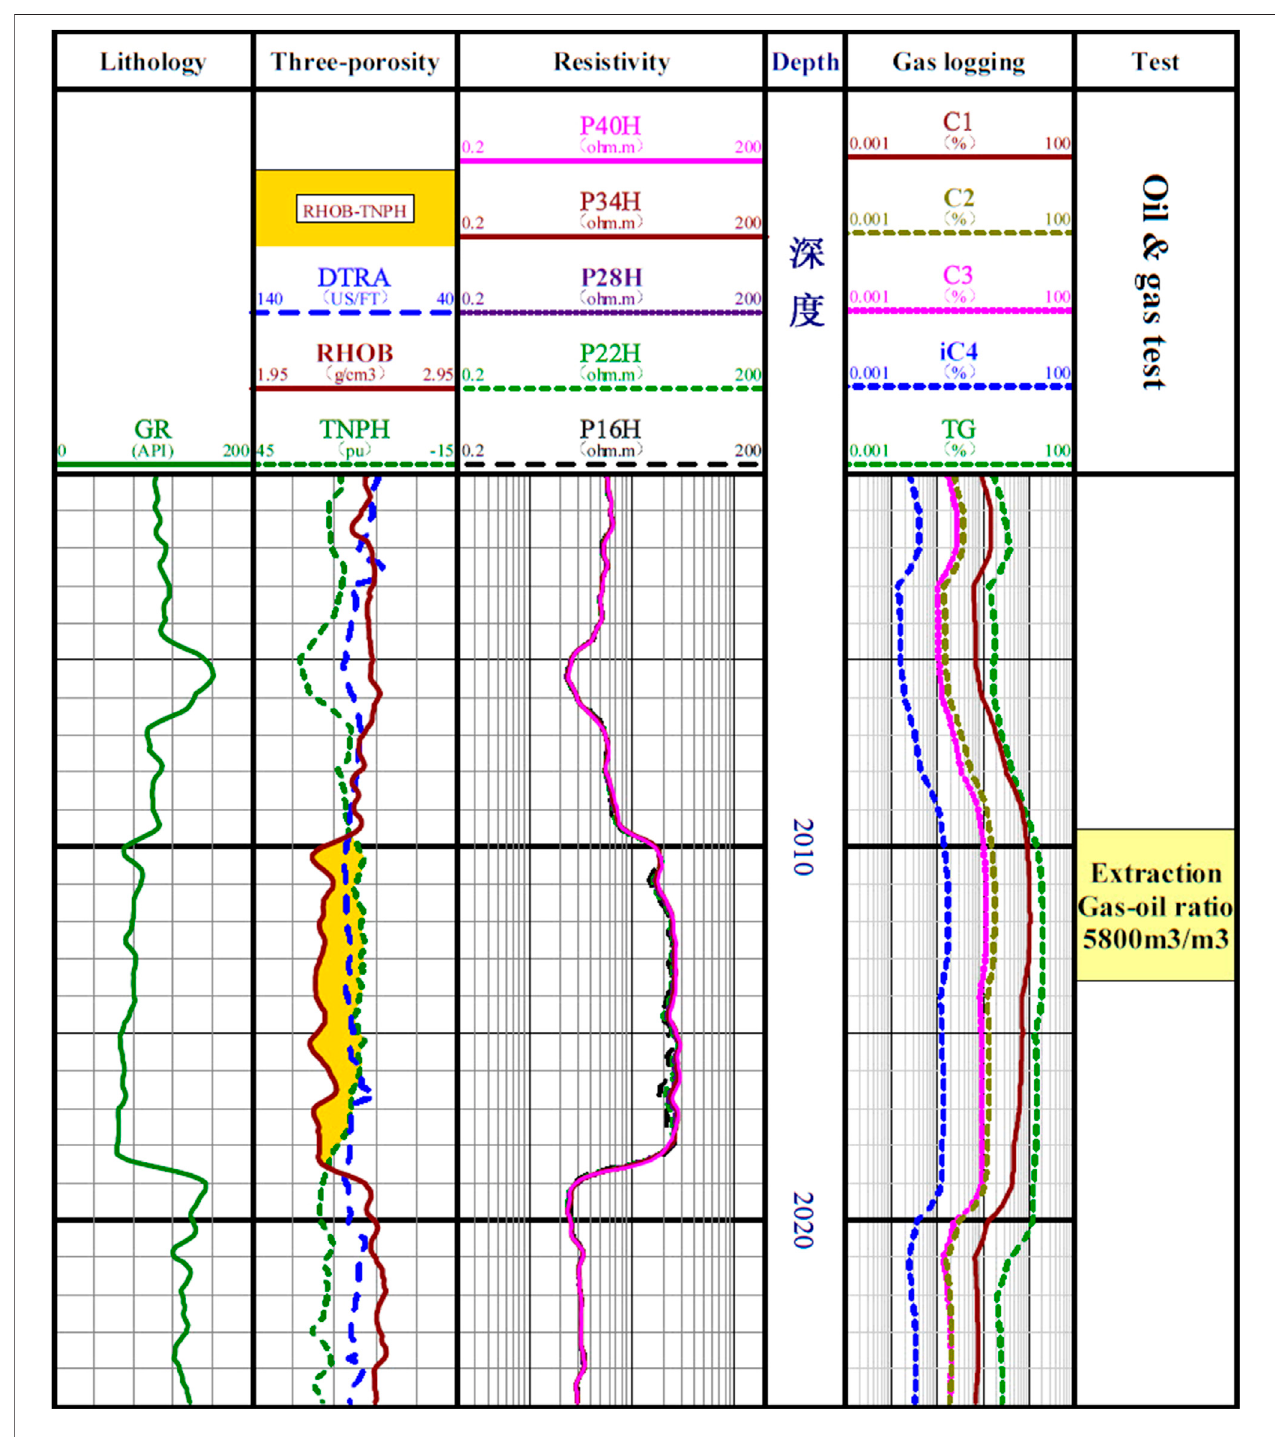
FIGURE 1 | Conventional logging and gas logging information of well O-A1 (2000 – 2025 m).